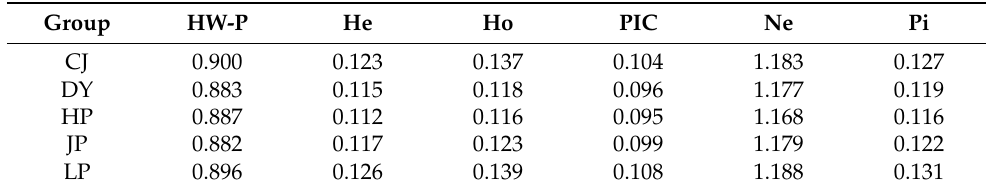
Table 1. Genetic diversity parameters of five populations of golden-backed carp in Guizhou, China, based on 44,896 SNPs.